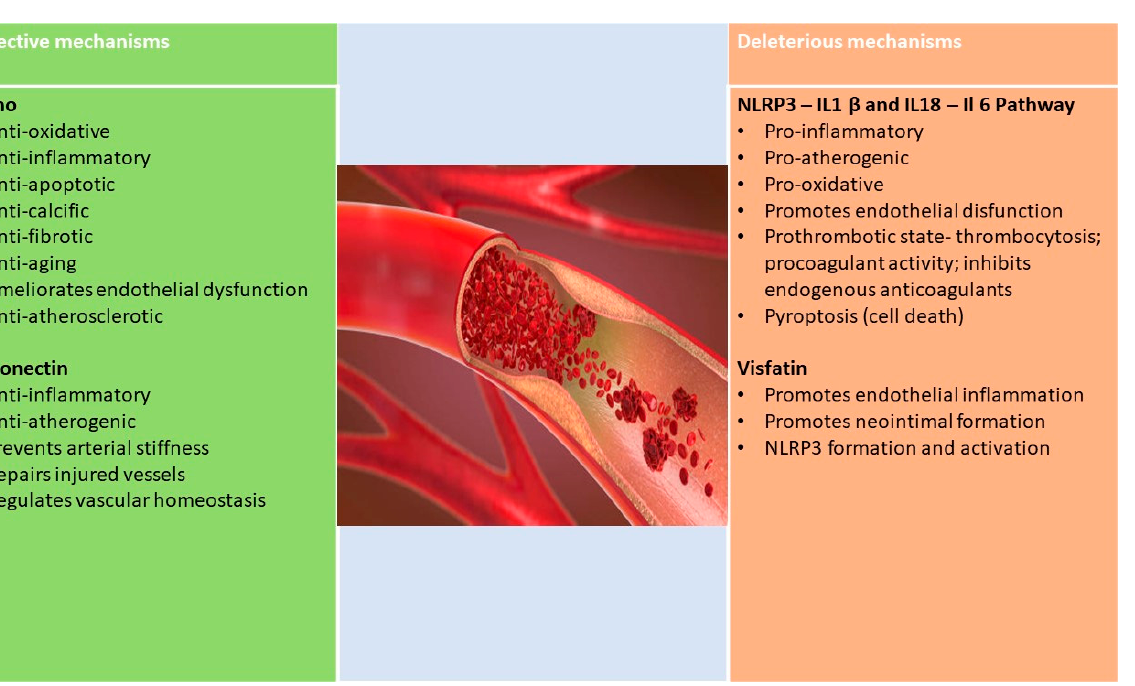
Figure 4. Protective vascular effects of Klotho proteins and adiponectin vs deleterious effects of NLRP and visfatin.